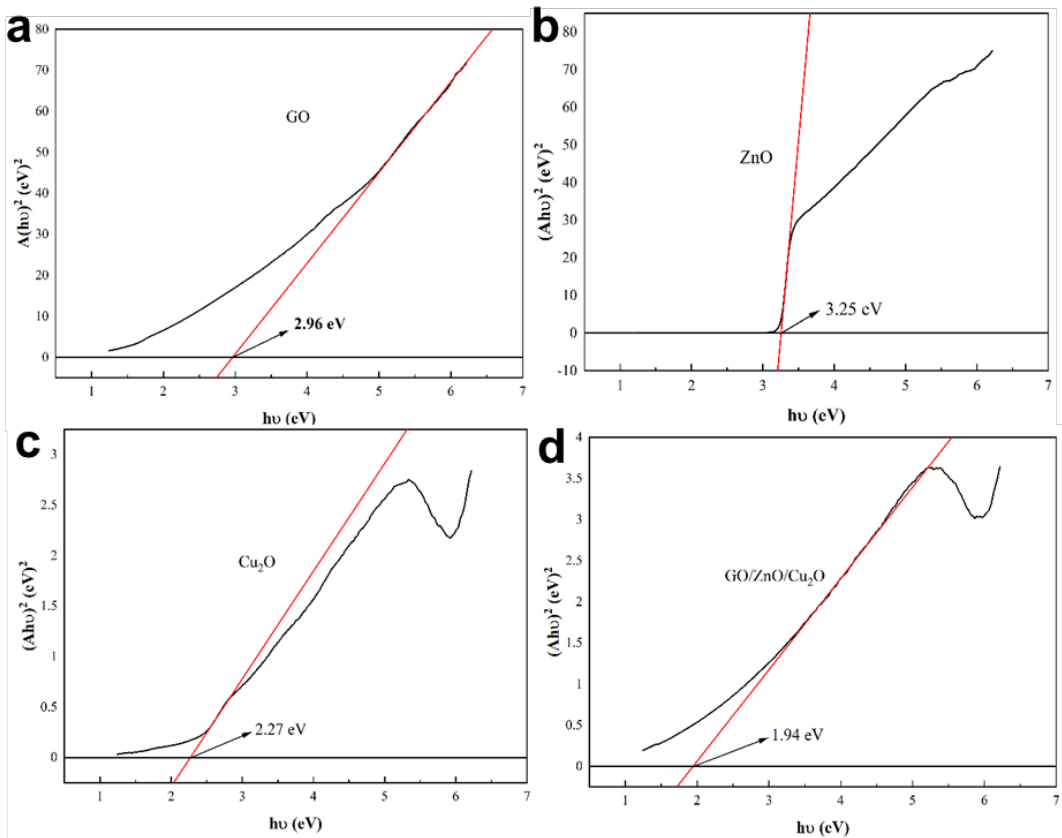
Figure 9. Tauc diagram of each powder sample. ( a ) GO. ( b ) ZnO. ( c ) Cu 2 O. ( d ) GZC antibacterial powder.